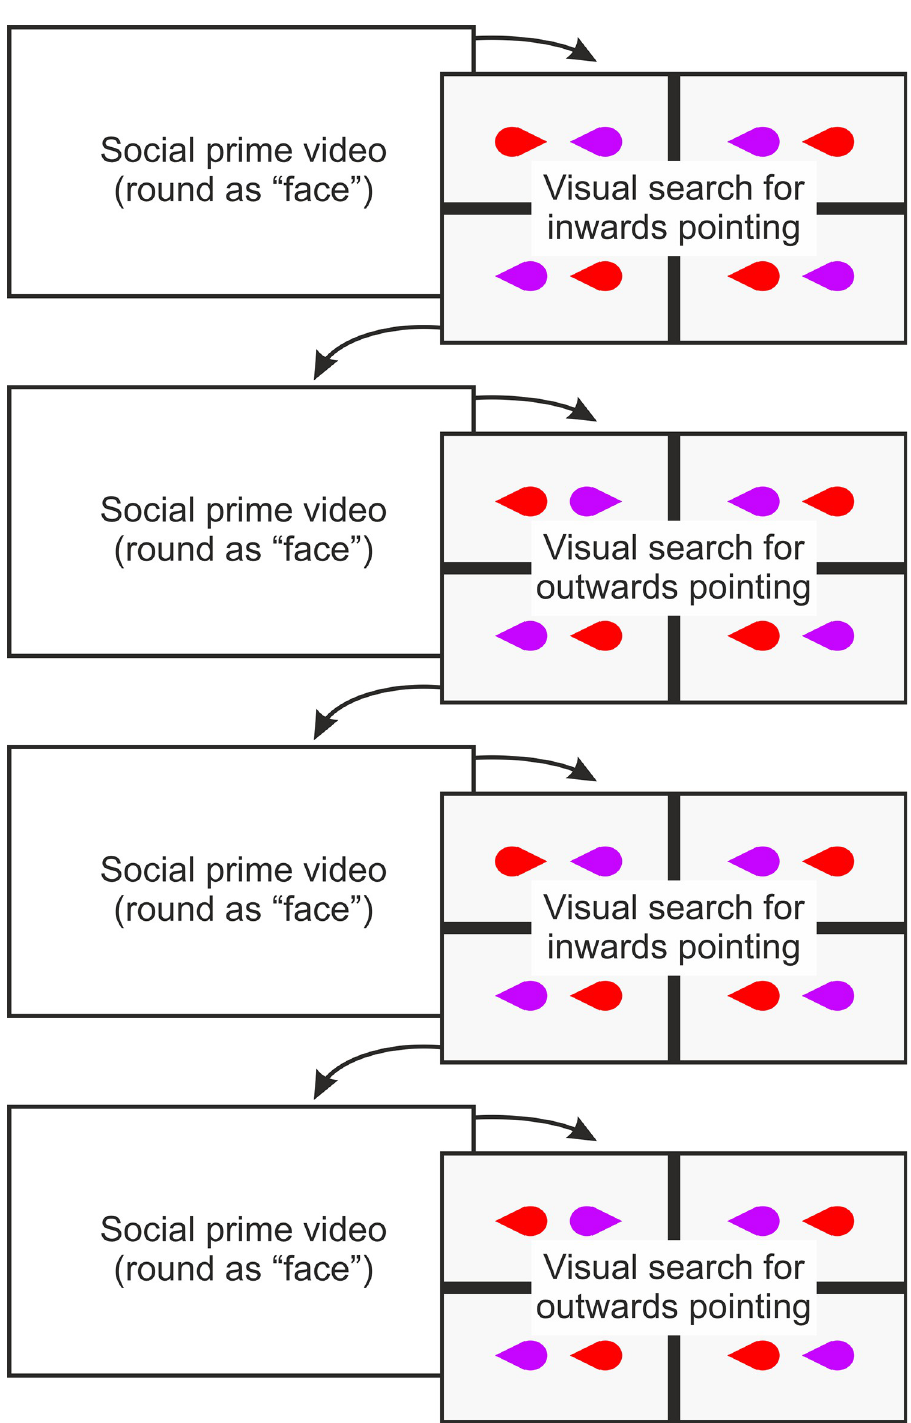
Fig 8. Schematic of experiment design demonstrating the progress of a participant in the round “face” social prime condition with inwards-outwards-inwards-outwards visual search blocking.